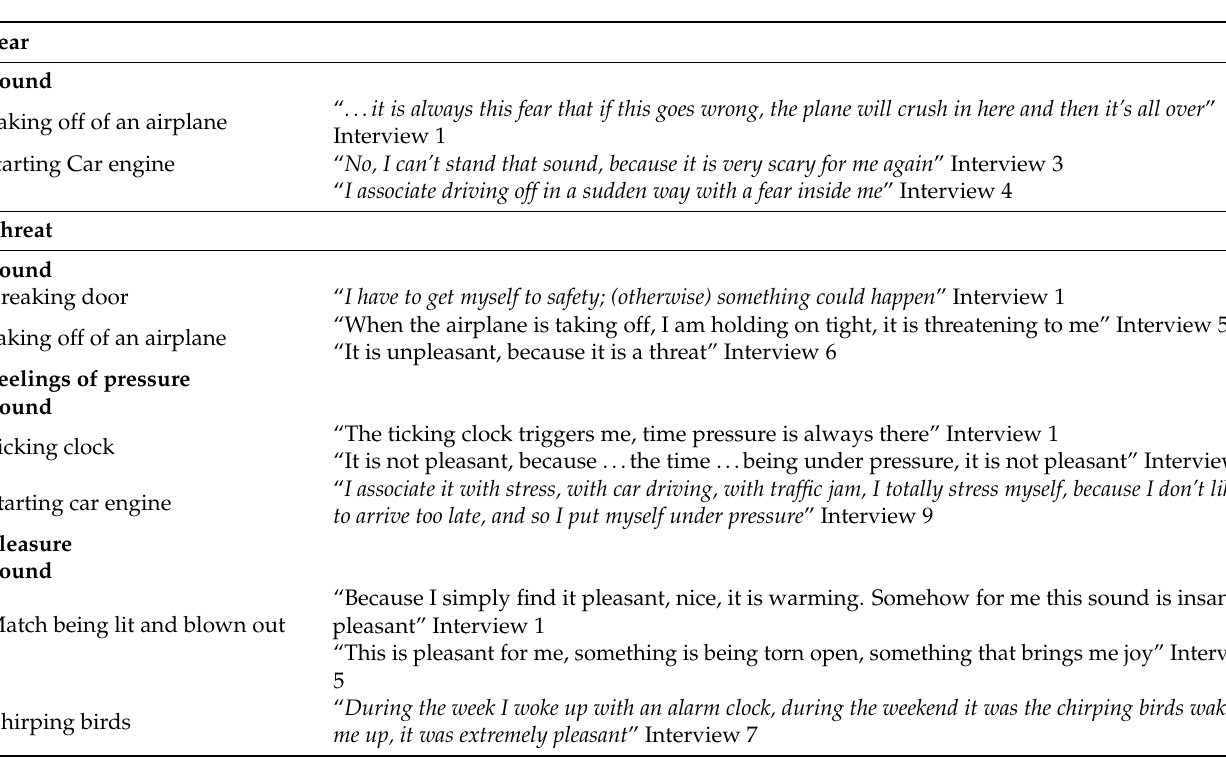
Table 4. Identified affective factors and corresponding